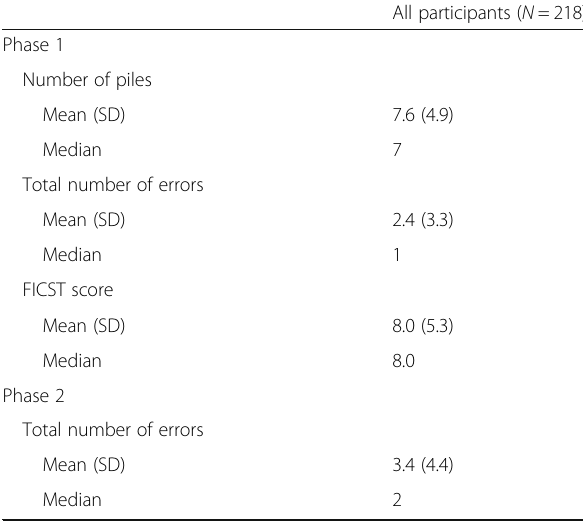
Table 3 Normative data — numbers of piles and errors expressed in the Facial Identity Card Sorting Test (FICST)